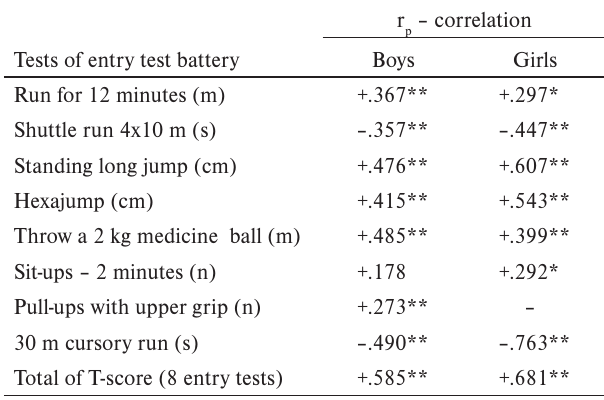
Prediction validity – the evaluation of entry tests with regard to the overall criteria – point results in the athletic polyathlon (time difference of 4